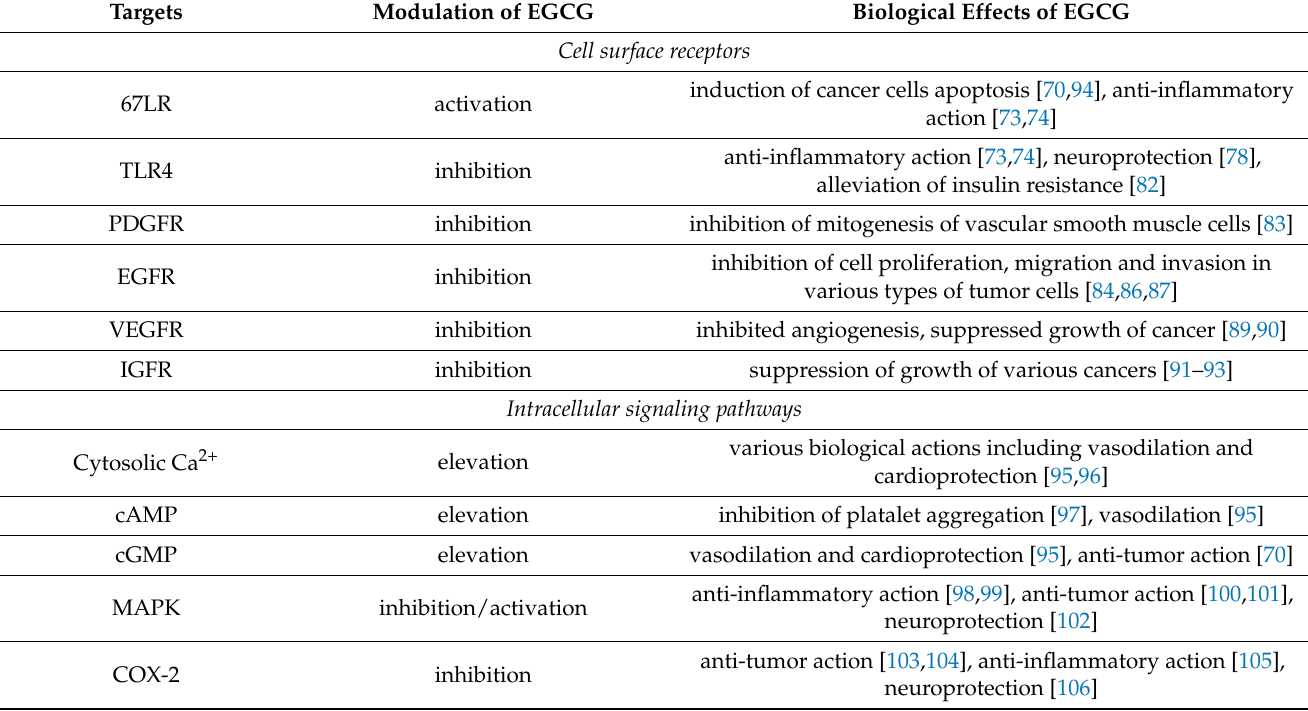
Table 1. Targets and major biological actions of